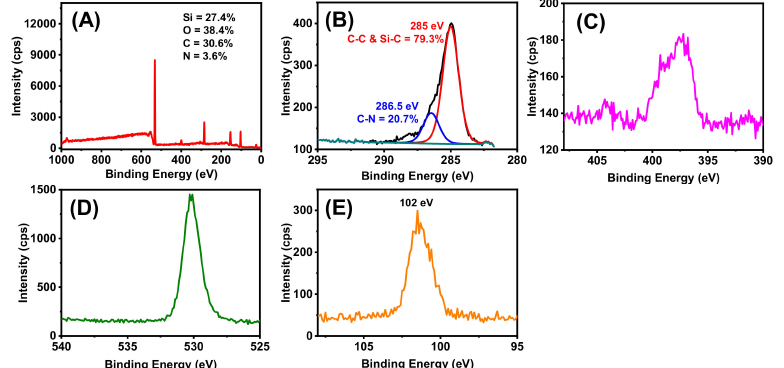
Figure A2. XPS analysis of APTMS on plasma cleaned SiO 2 surface. ( A ) wide, ( B ) C 1s, ( C ) N 1s, ( D ) O 1s, and ( E ) Si 2p